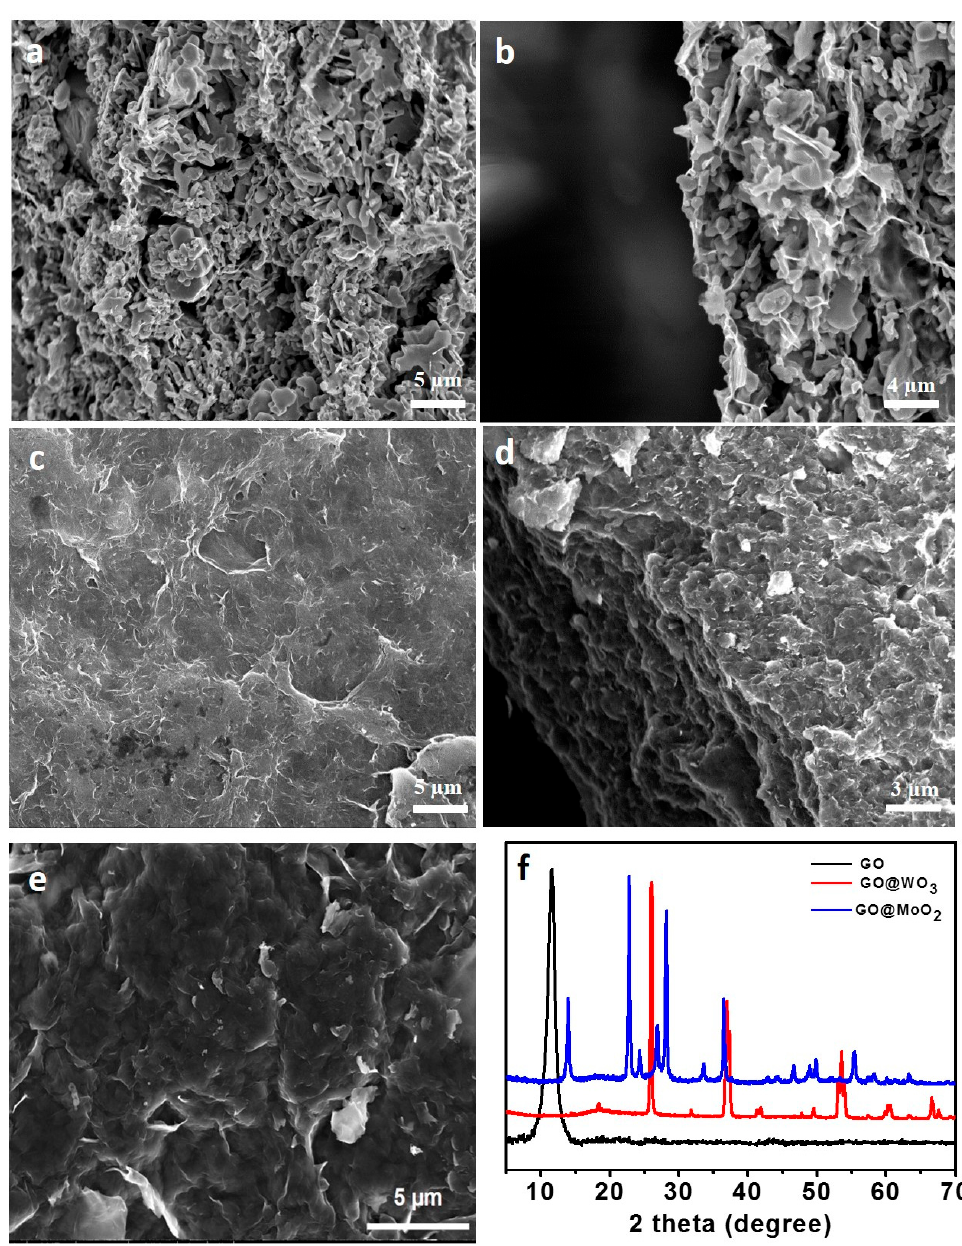
Figure 1. Surface and cross ‐ sectional images of ( a , b ) MoO 2 @GO and ( c , d ) WO 3 @GO nanocomposite membranes, respectively. ( e ) Surface SEM image of pristine GO membrane. ( f ) XRD pattern of GO ‐ based membranes.